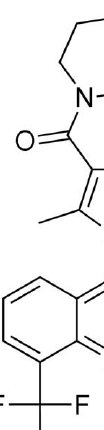
software used to prepare material for publication: PLATON (Spek,